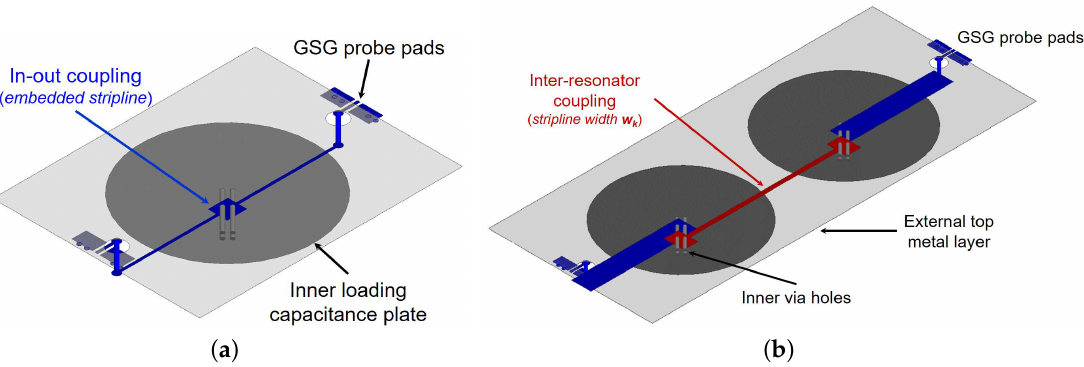
Figure 5. Layout of the proposed magnetic ( a ) external and ( b ) inter-resonator coupling mechanisms based on stripline probes short-circuited to the inner posts of the CSIW resonators. Please note that bottom layer and via holes that form the SIW cavity walls are not shown for improving